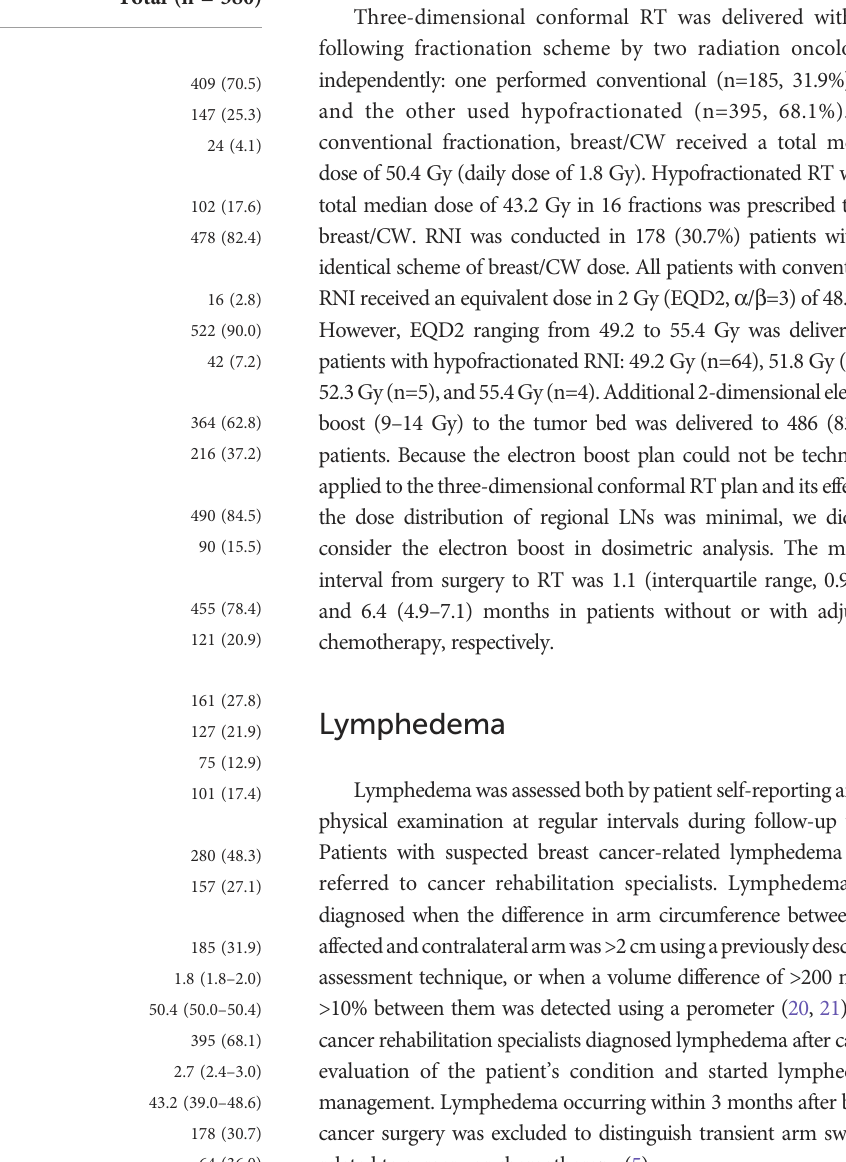
TABLE 1 Baseline characteristics of all patients (n =